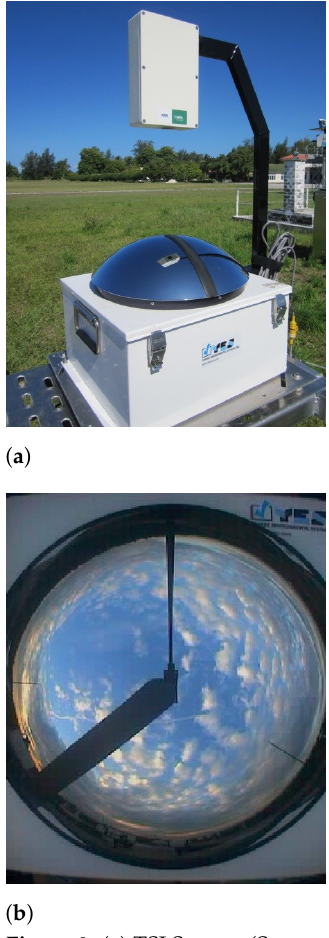
Figure 2. ( a ) TSI System (Source: [21]) ( b ) Sample image captured by TSI